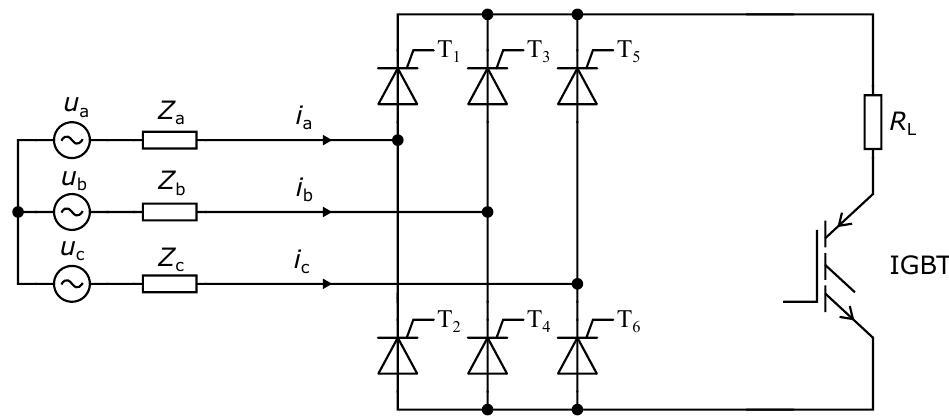
Figure 2. Impedance identification circuit for 20kV medium voltage